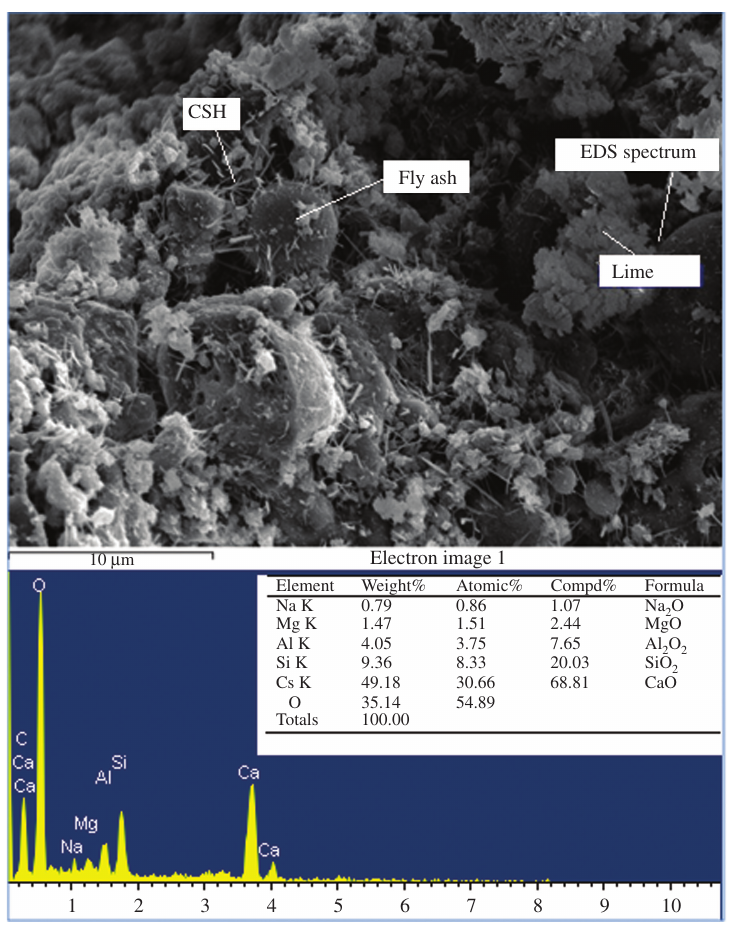
Figure 9 Secondary electron image of FA and